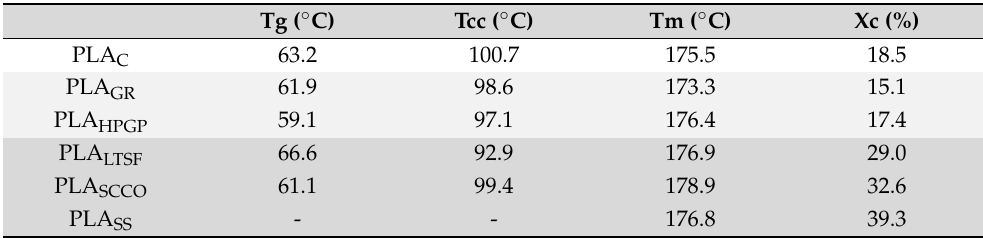
Figure 4. DSC thermograms for PLA discs subjected to the different sterilisation treatments: PLA GR , PLA SCCO , PLA LTSF , PLA SS and PLA HPGP together with the untreated PLA disc as control, PLA C . Table 5. Glass transition temperatures (Tg), cold crystallisation (Tcc), crystalline melting (Tm) and crystallinity index of PLA subjected to the different sterilisation treatments: PLA GR , PLA SCCO , PLA LTSF , PLA SS and PLA HPGP together with the untreated control, PLA C